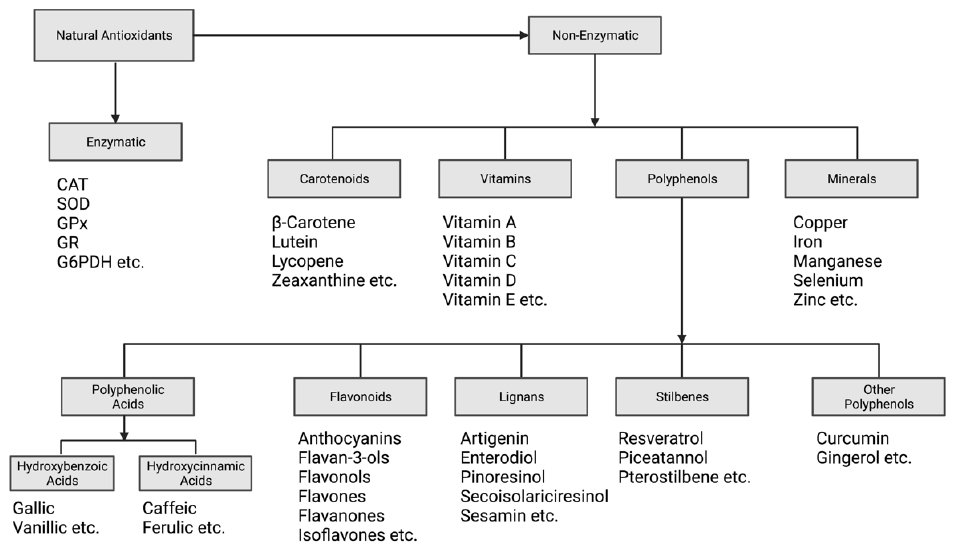
Figure 3. Schematic diagram of classification of natural antioxidants. Created with BioRender.com. CAT, catalase; SOD, superoxide dismutase; GPx, glutathione peroxidase; GR, glutathione reductase; G6PDH, glucose-6-phosphate dehydrogenase.